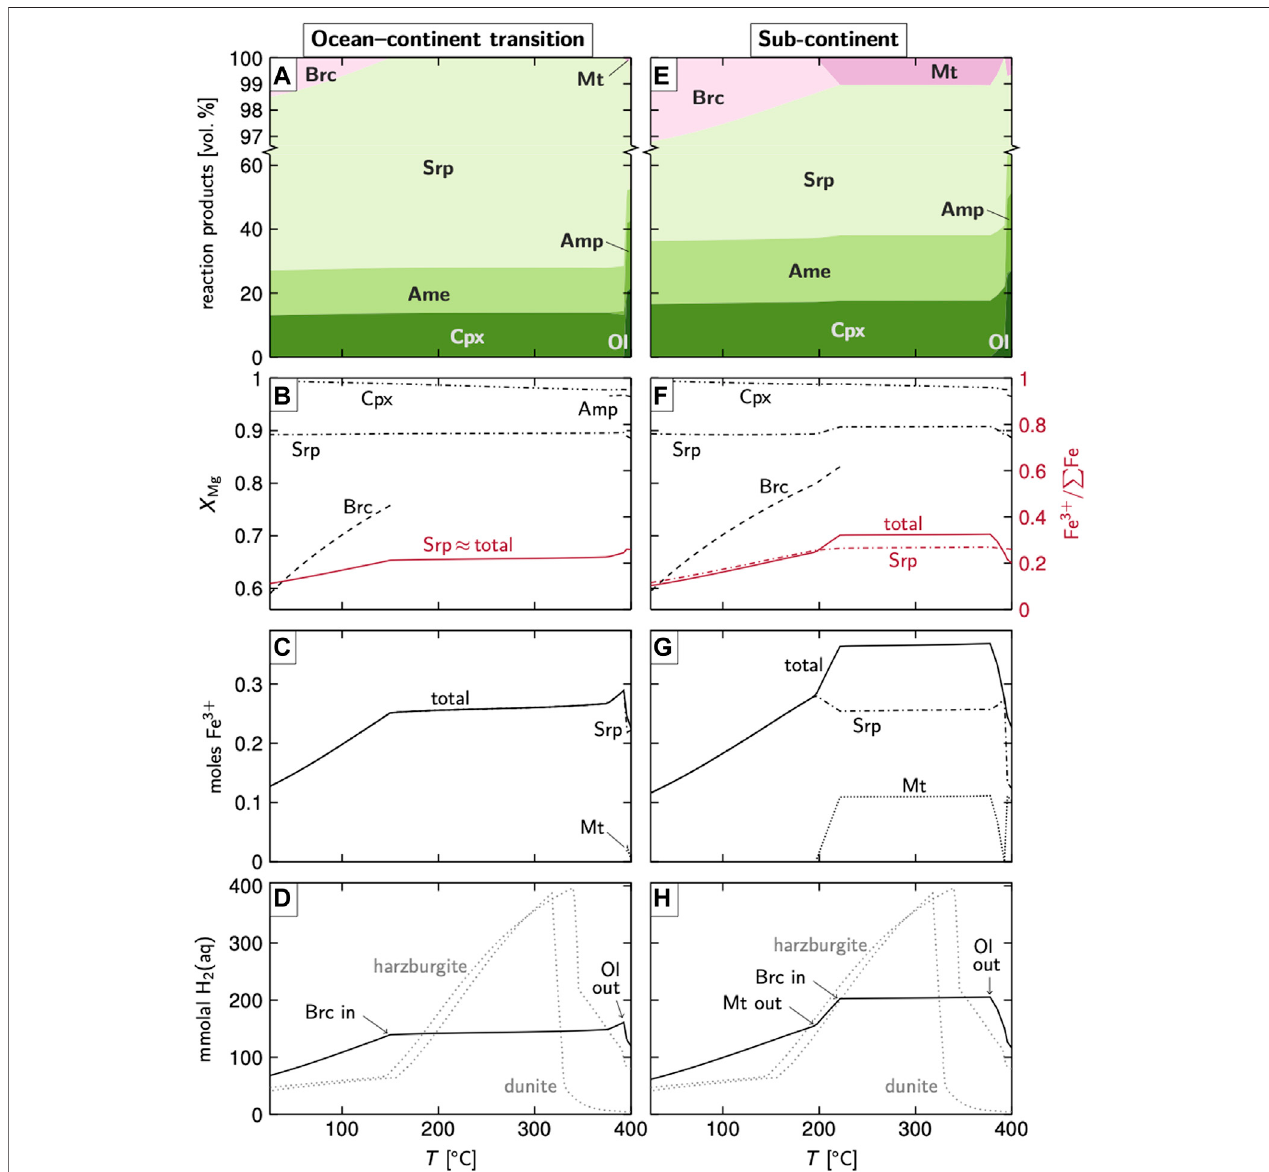
FIGURE6| ThermodynamicmodelingresultsusingbulkcompositionsrepresentativeofrocksfromproximaldomainsofanOCT (A – D) andtheSCLM (E – H) atw/r (cid:1) 1. The formation of garnet is suppressed in these runs. Plots (A) and (E) show predicted equilibrium mineral assemblages (B) and (F) show Fe – Mg relations of the stable phases and the oxidation states of Fe (C) and (G) give the amounts of Fe(III) per kg rock, and (D) and (H) depict the respective amounts of H 2 (aq) produced from the oxidation of Fe. Amounts of H 2 (aq) predicted for the hydration of harzburgitic and dunitic rocks are shown for comparison (Klein et al.,